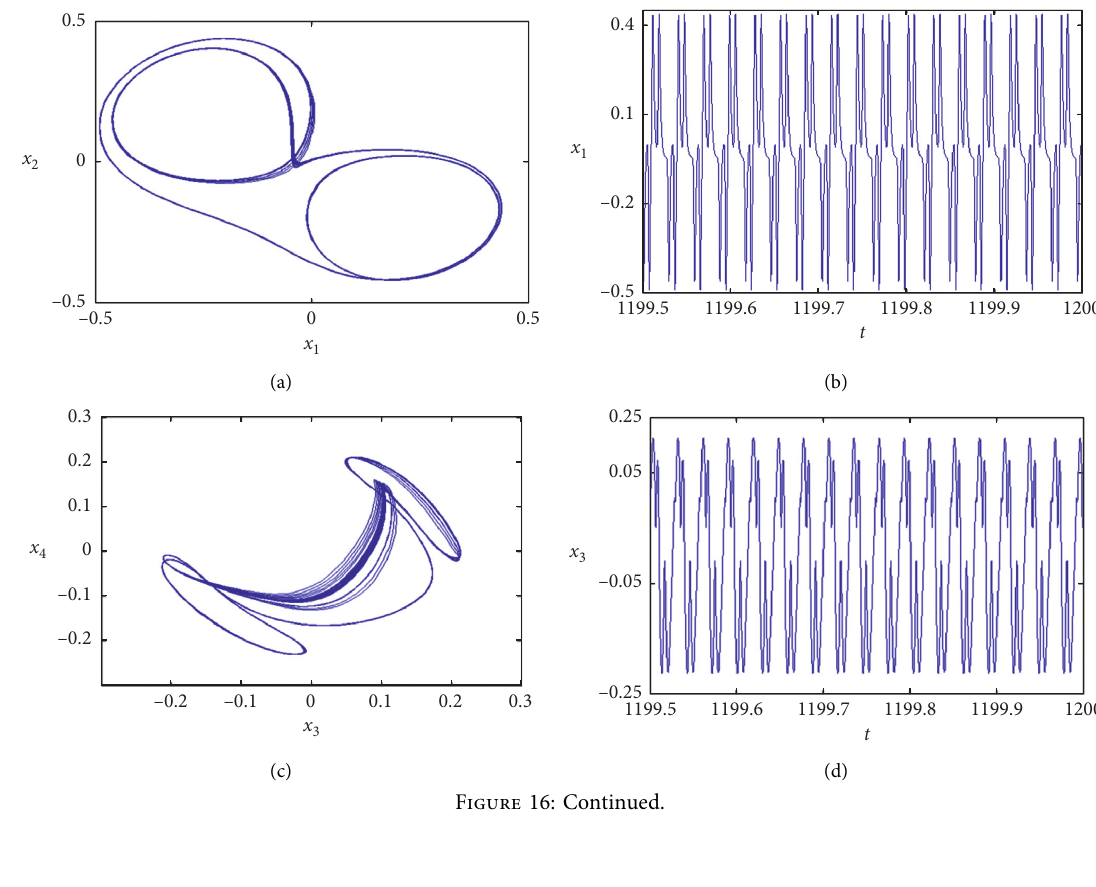
, x ) , (b) waveform on plane ( t, x ) , (c) phase portrait on plane ( x 1 2 1 ,x , x ) , and (g) Poincare map on plane ( x 1 2 3